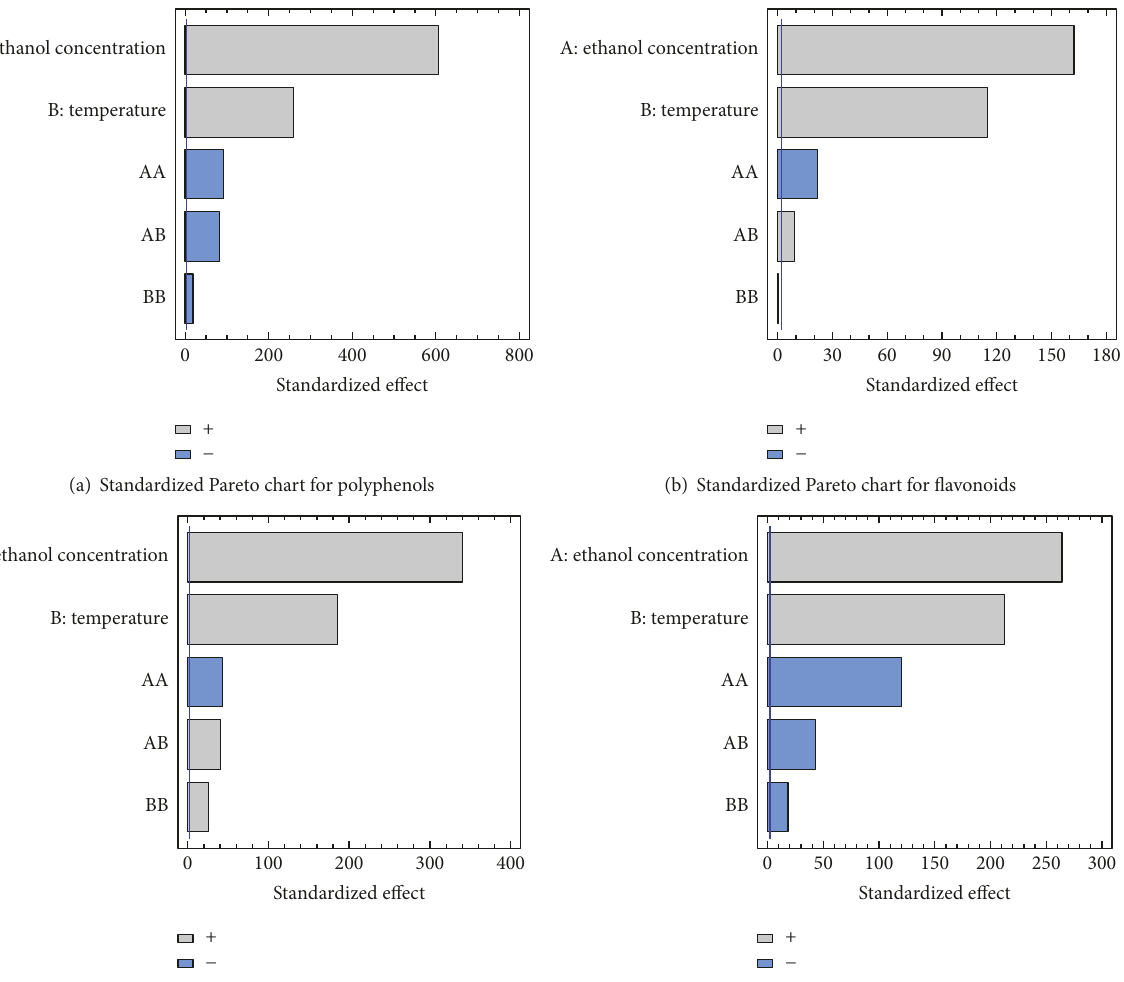
Figure 6: Standardized Pareto chart. Analysis shown for polyphenols (a), flavonoids content (b), tannins content (c), and antiradical activity (d). The variables are temperature and ethanol concentration. It shows the columns/parameters crossing the vertical blue line, which are statistically significant with more than 95% of